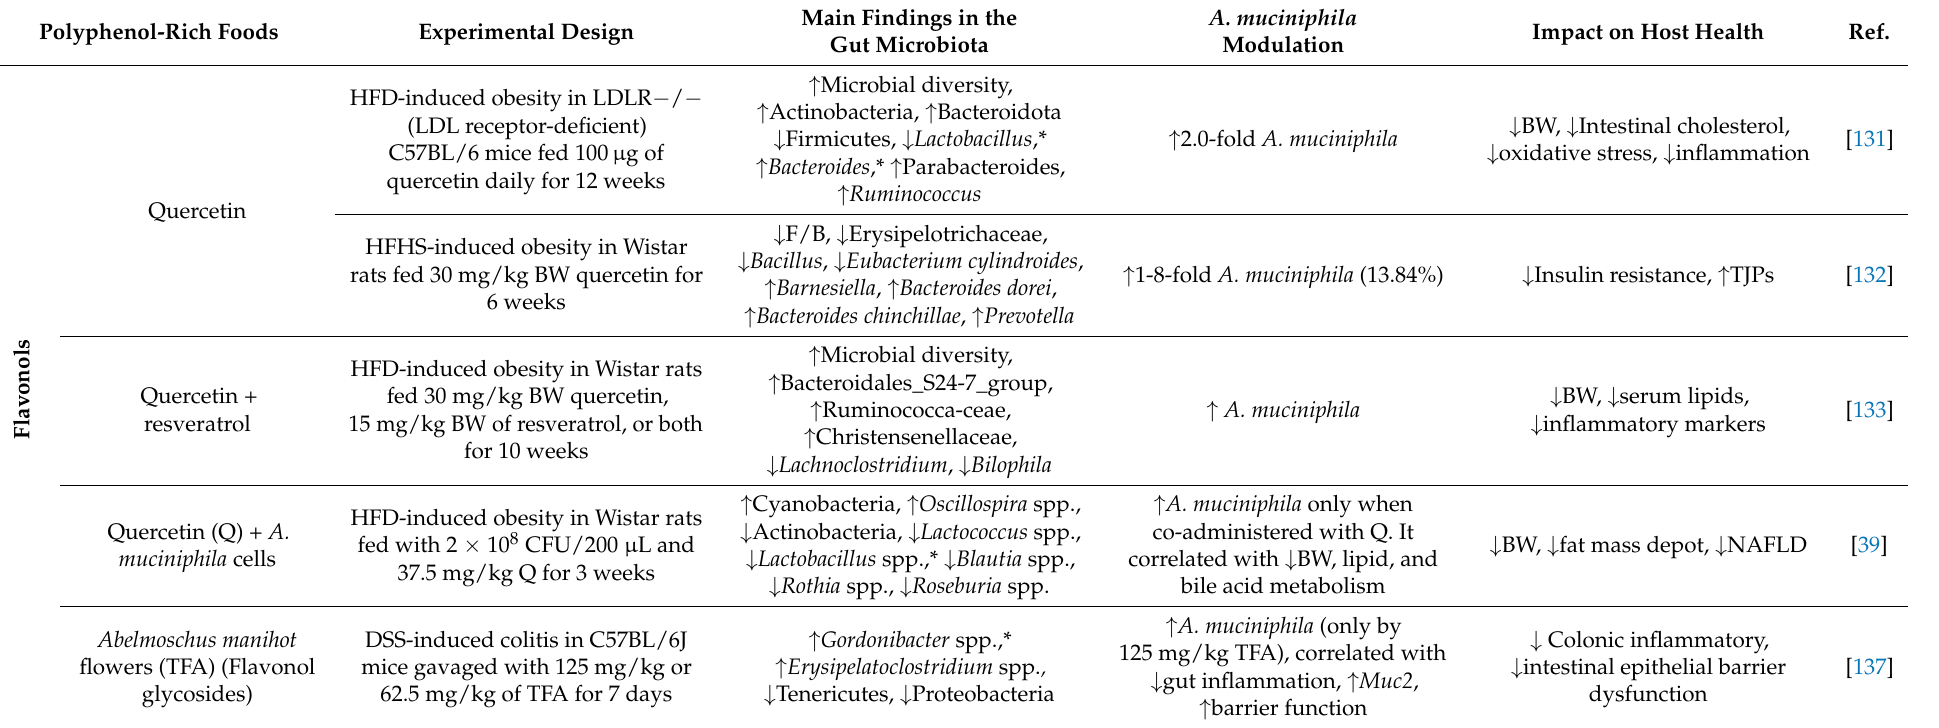
Table 4. Modulation of the gut microbiota by flavonols and flavonol glycosides in animal